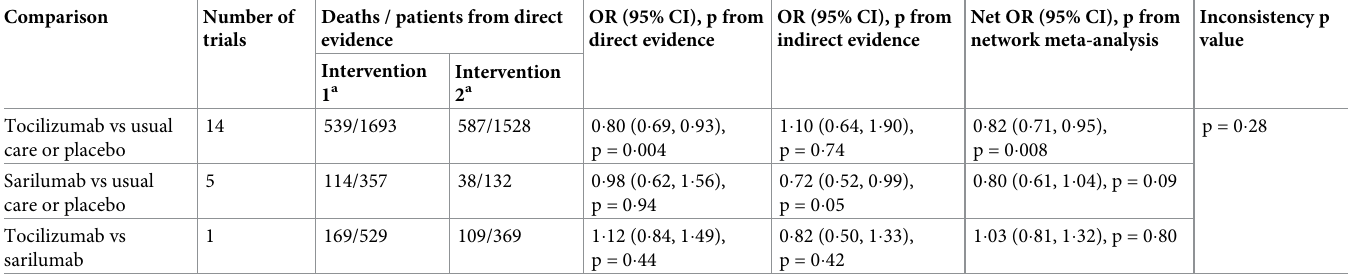
Table 2. Summary of direct, indirect, and net evidence for the associations of tocilizumab, sarilumab and usual care or placebo with all-cause mortality 28 days after randomisation for patients receiving corticosteroids and either NIV, IMV or ECMO at randomisation.